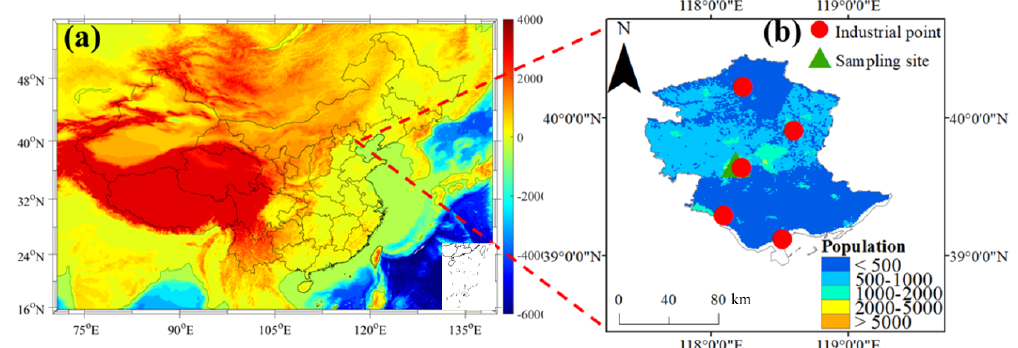
Figure 1. Topographic map of China indicating the location of Tangshan (a) , the sampling site (b) , and some major industrial points (b) . The population distribution of Tangshan is also depicted in (b)